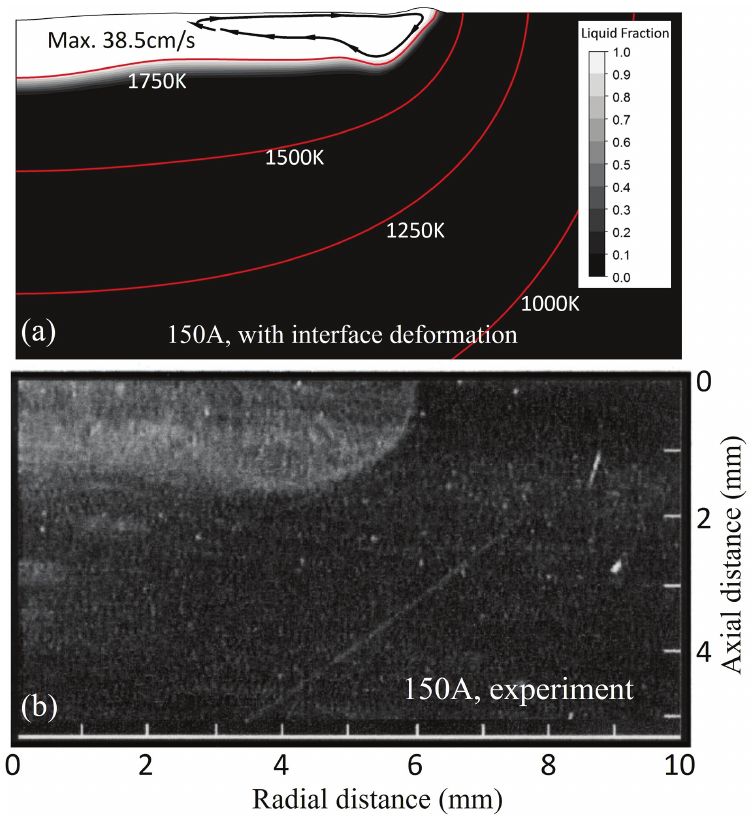
Figure 12: Comparison of weld pool shape between (a) simulation with interface deforma- tion and (b) experiment